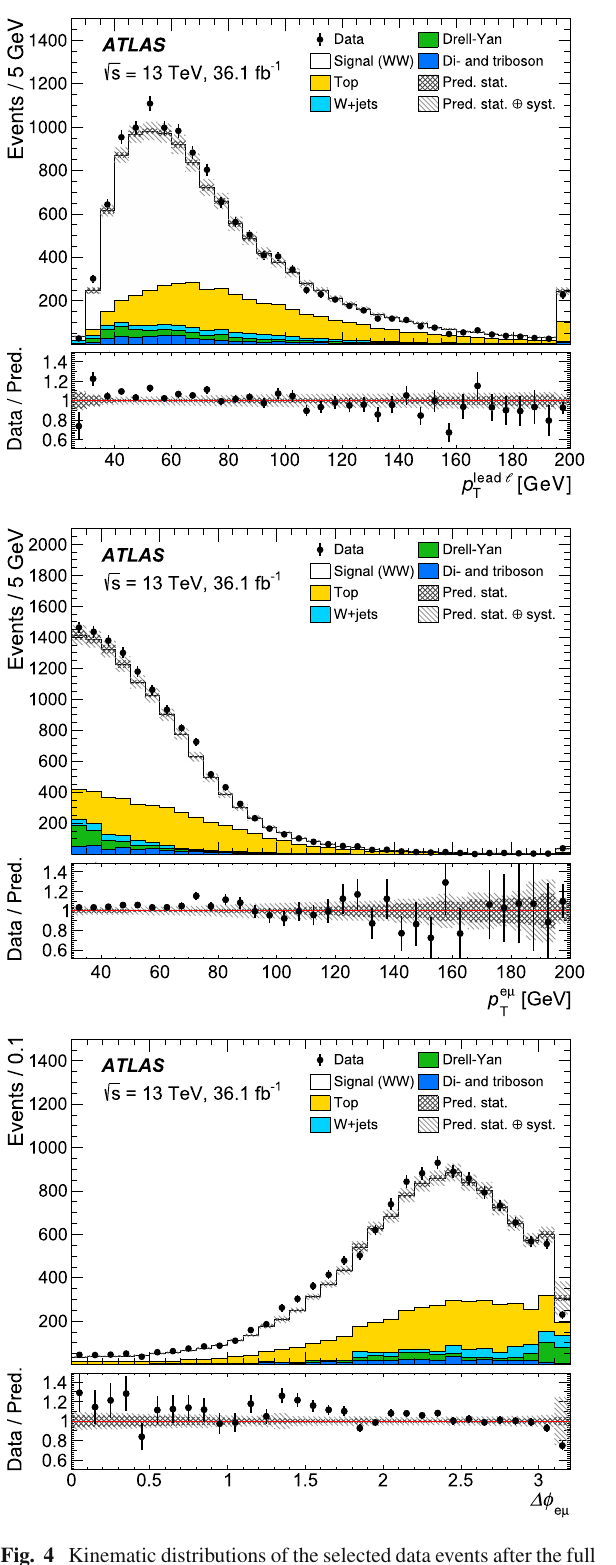
tematicuncertaintiesinthepredictionsareshownashatchedbands.The μ , m e μ , p e , lower panels show the ratio of the data to the total prediction. An arrow T T indicates that the point is off-scale. The last bin includes the